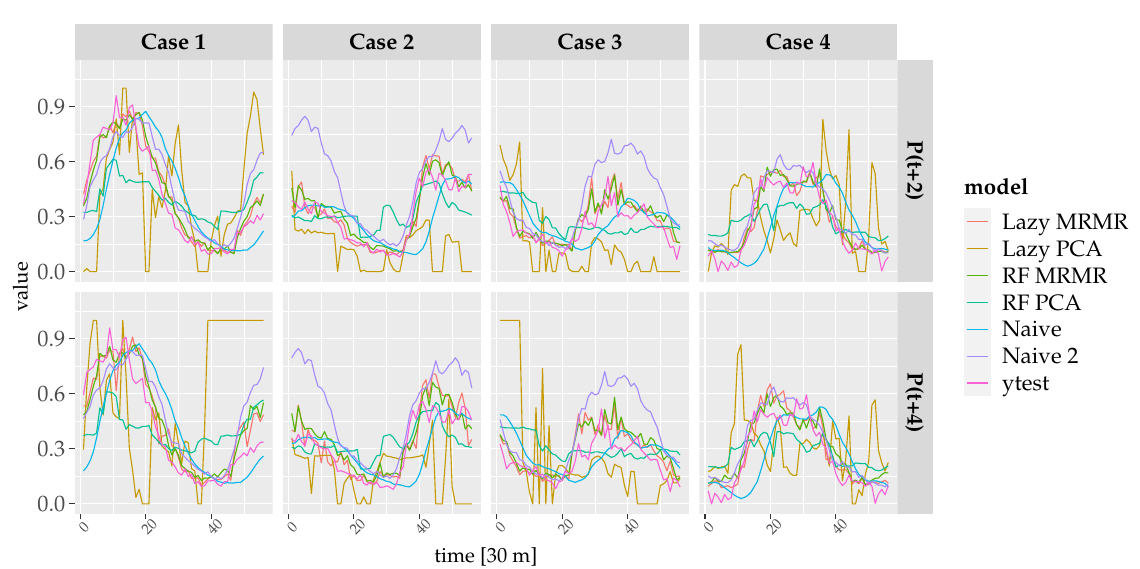
Figure 8. Visualization of actual ( ytest ) and predicted load trajectories for a 2 h forecasting